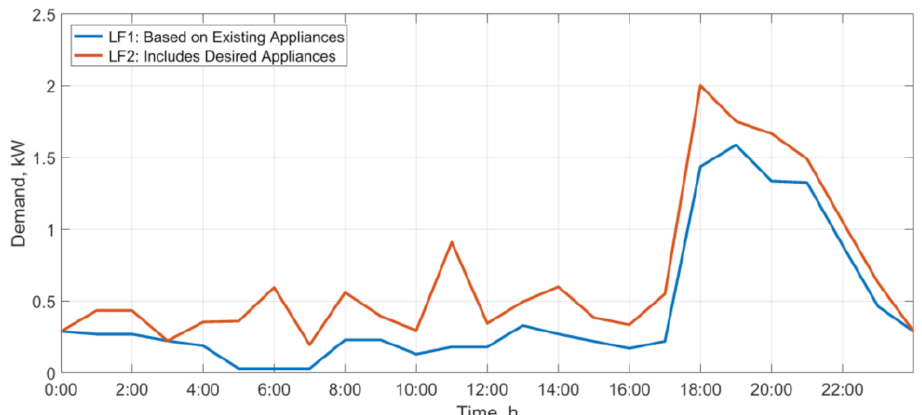
Figure 12. Estimated load profiles of the Gilutongan Island rooftop solar microgrid based on two scenarios: the first considers only the existing electrical loads (scenario LF1, blue curve), and the second considers additional loads desired by HH2 and HH8 (scenario LF2, red